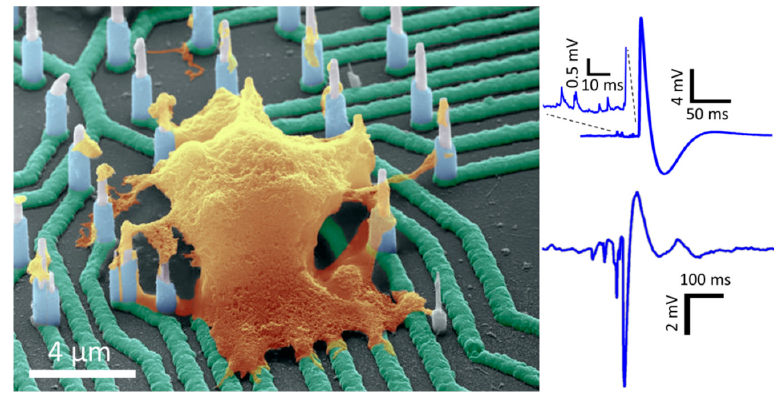
Figure 29. The electrical circuit model of the electro-neural system starts with the cell culture (yellow) interfacing with the electrode, all the way to the read-out electronics represented by the amplifier block (green). Reprinted with permission from [197]. Copyright (2017) American Chemical Society.